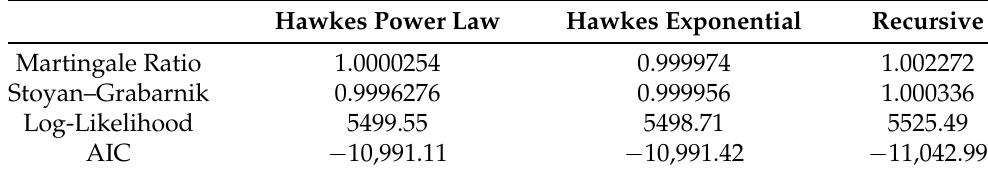
Table 1. Test Result Comparison